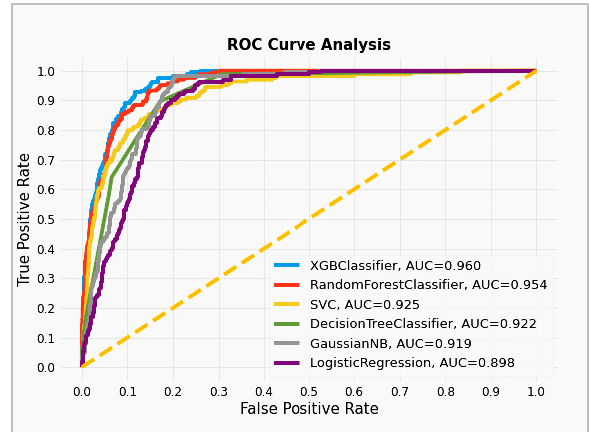
Figure 5. ROC Curve Analysis with AUC score comparison